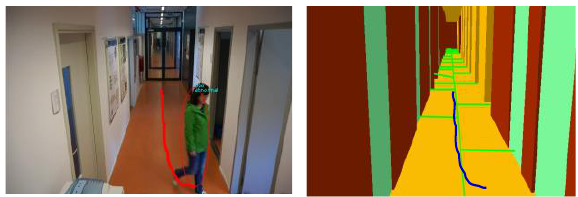
Figure 4 the result of matching video trace to 3D indoor path: the computed trace in red (left) and the matched trace on the 3D indoor model (in blue)